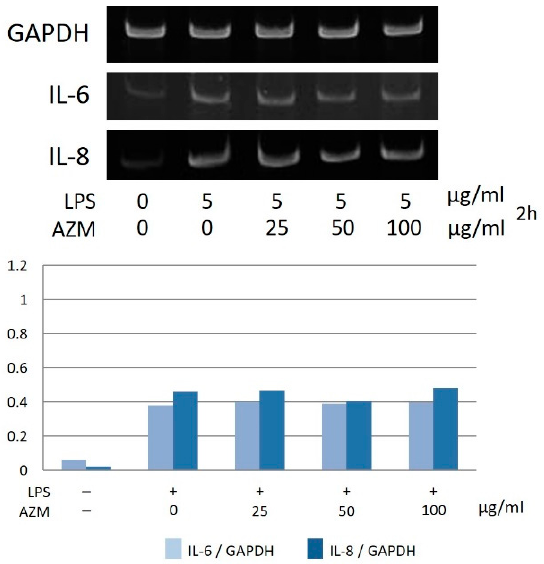
Figure 8. Gene expression of IL-6 and IL-8 in hPLFs in the presence of LPS and AZM. The most typical data were shown.